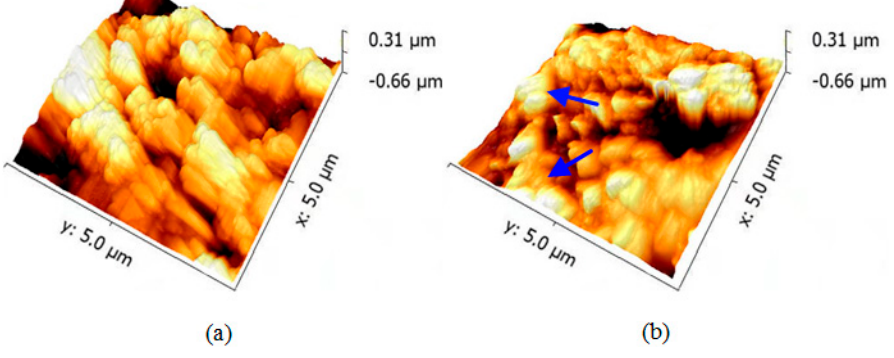
Figure 9. Atomic force microscope (AFM) images of the ( a ) as-prepared and ( b ) worn super-hydrophobic coatings.